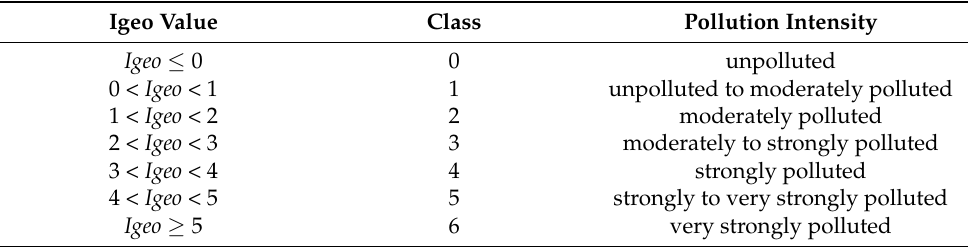
Table 2. Level of pollution with heavy metals according to Igeo